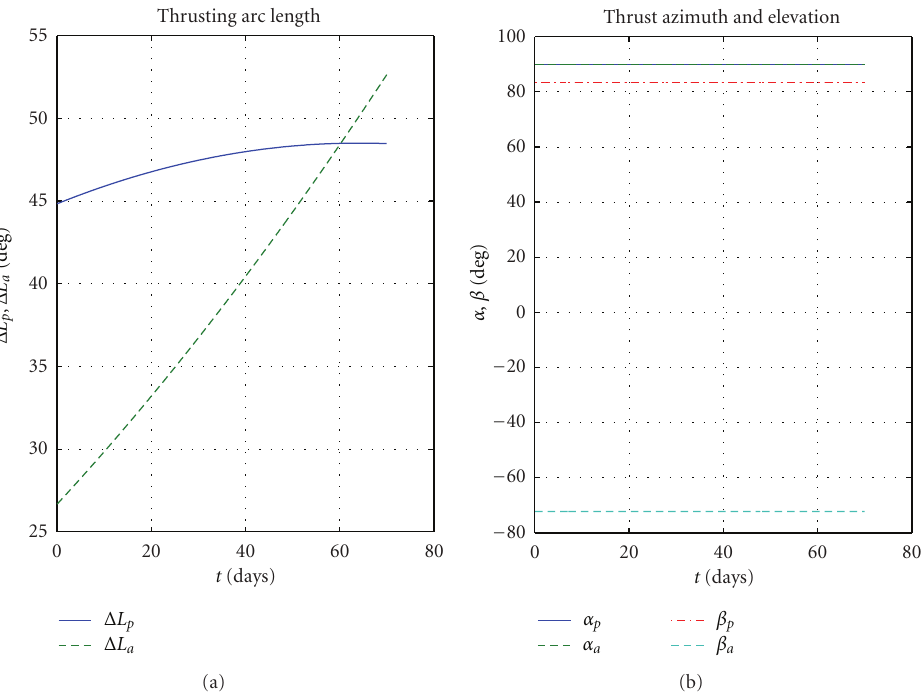
Figure 10: Control parameters for multirevolution orbital transfer (10 ◦ plane change): (a) thrust arc length; (b) azimuth and elevation.